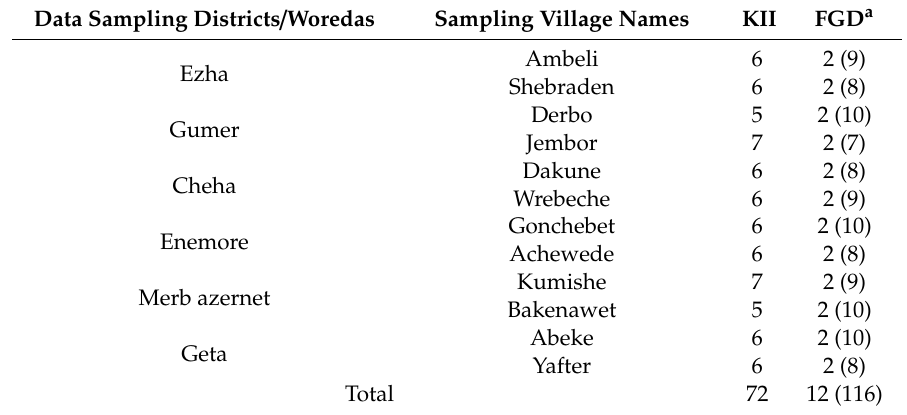
Table 2. The numbers and types of participants for habitat threats data collection. Data Sampling Districts /